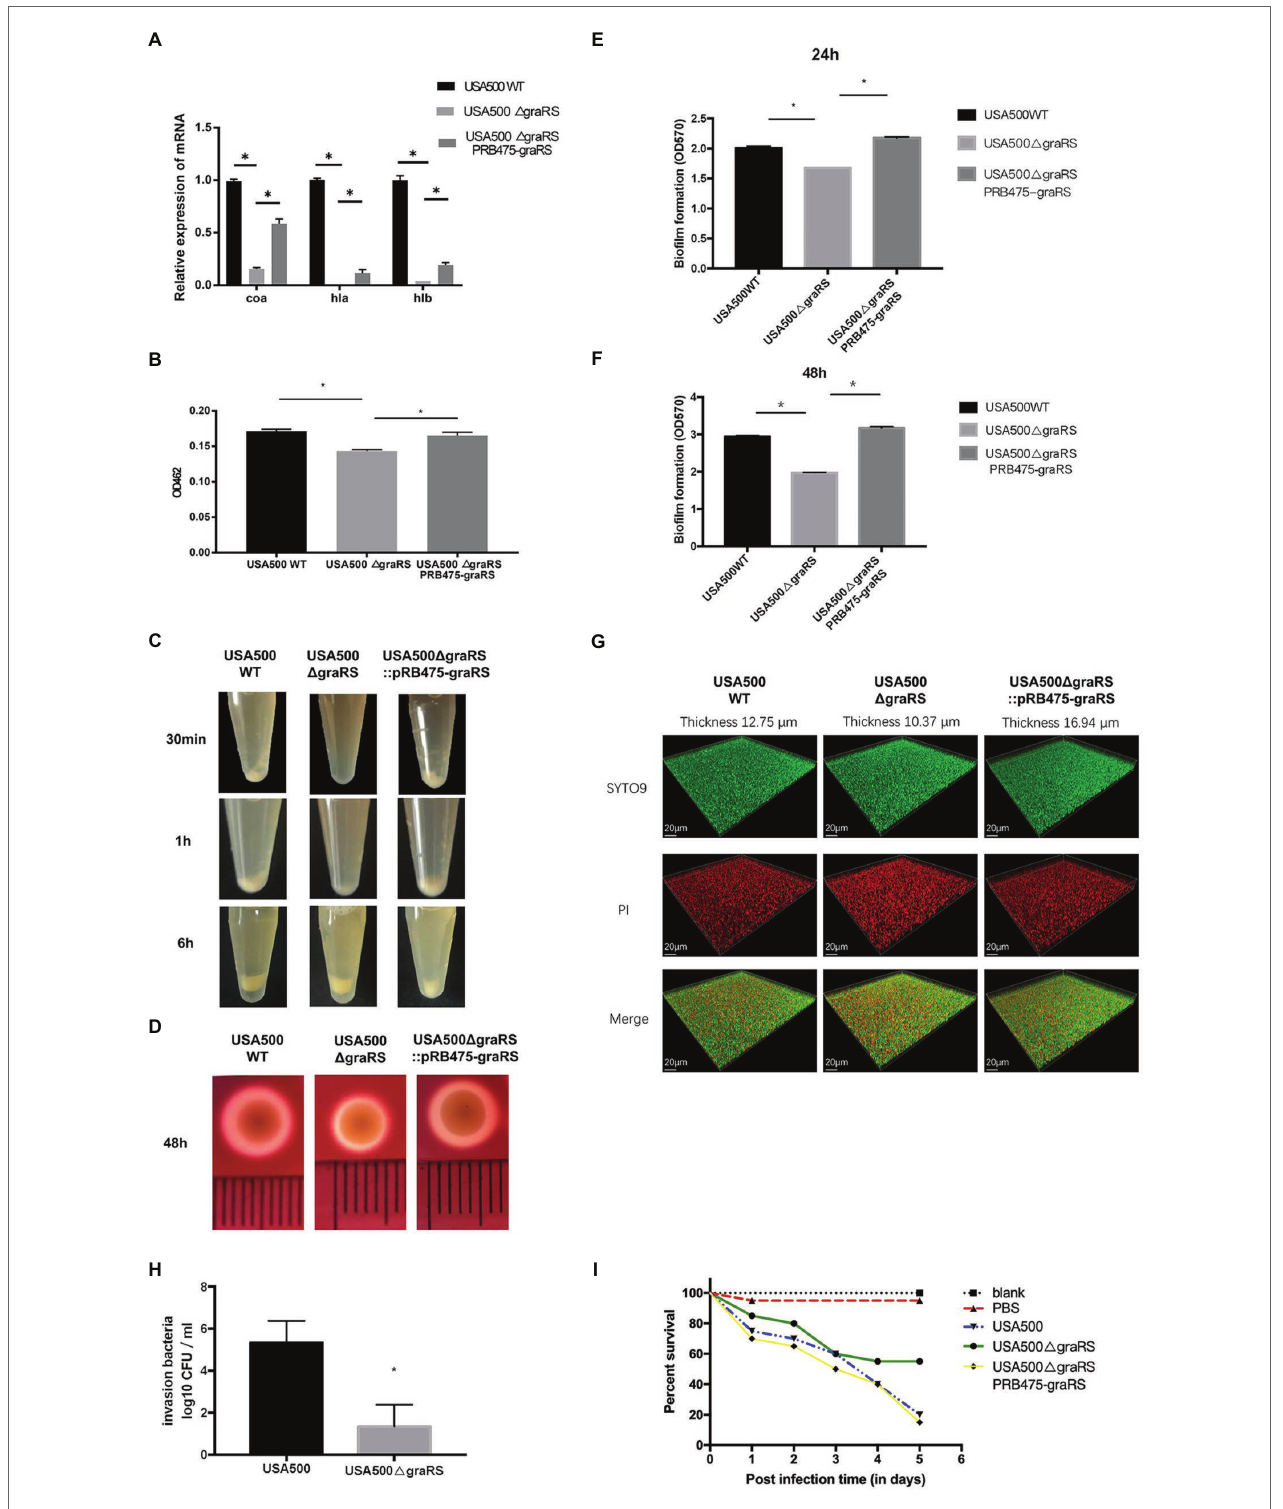
FIGURE 2 | The effect of graRS knockout on the expression of the virulence-associated genes, virulence phenotypes and biofilm formation. (A) Transcriptional levels of the virulence genes in USA500WT, USA500 Δ graRS , and USA500 Δ graRS:: pRB475- graRS strains were detected by qRT-PCR. (B) The effect of graRS deletion in the USA500 on the carotenoid pigment formation. (C) The effect of graRS knockout in the USA500 on the coagulase activities at 30 min, 1, and 6 h. (D) The effect of